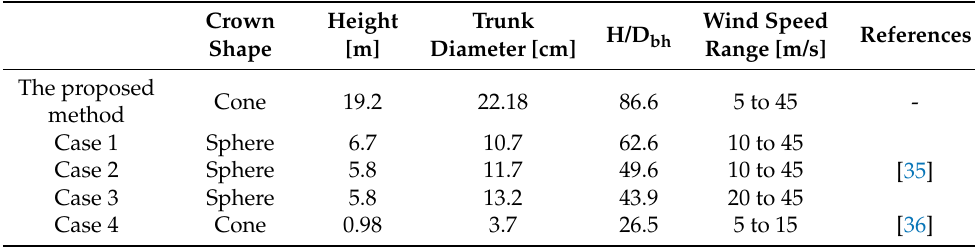
Table 5. Test conditions of the proposed method and the previous wind tunnel study.